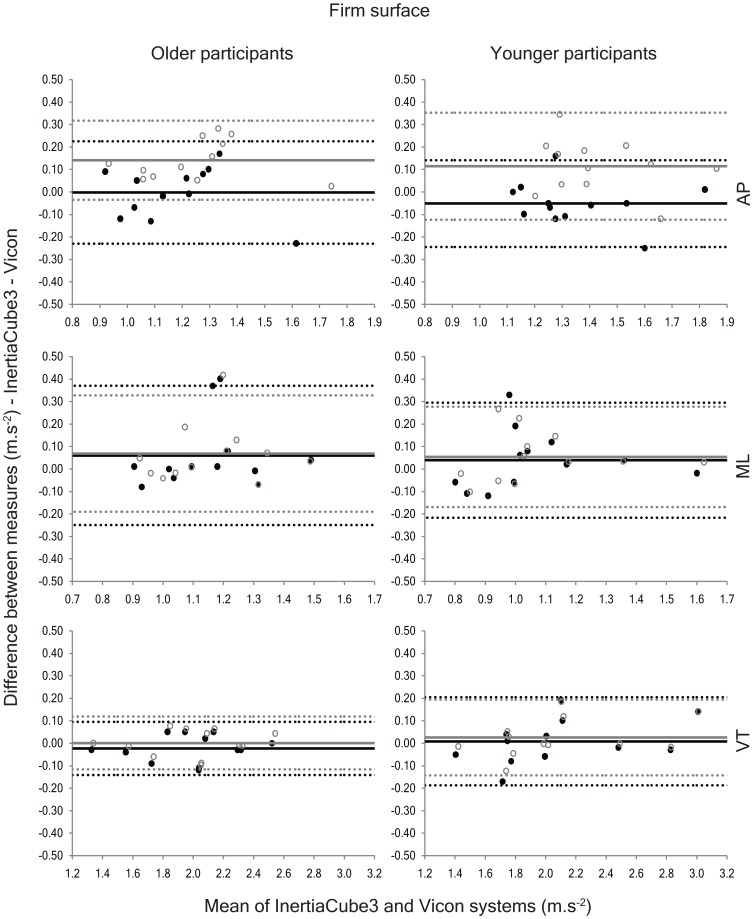
Bland-Altman plots depicting the agreement between the anteroposterior (AP), mediolateral (ML) and vertical (VT) accelerations collected using the InertiaCube3 and Vicon systems while walking on the firm walkway.The solid black circles represent the agreement between the two instruments using the detrending method and the open grey circles show the agreement using the quaternion method. The solid lines on the graphs represent the systematic bias between the two measures and the dashed lines portray the 95% limits of agreement (black = detrending method; grey = quaternion method).